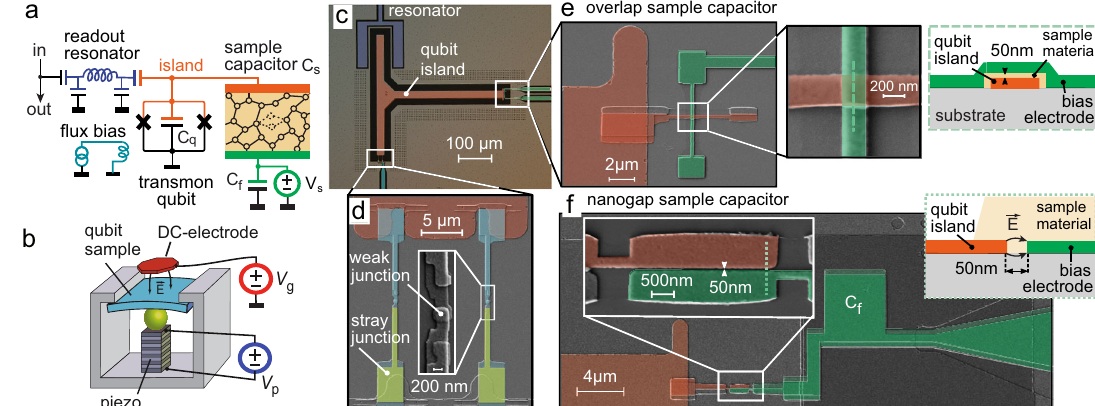
Fig. 1 Experimental setup and qubit sample. a Schematic of the transmon qubit circuit to study TLS in deposited materials. The qubit island (red) is connected to ground by an additional small capacitor containing the material to be studied. b Setup for tuning TLS by applied mechanical strain and a global DC-electric fi eld. c Photograph of the qubit island. d DC-SQUID connecting the qubit island to ground, and a zoom onto one of the small Josephson junctions. The large-area stray junctions are highlighted in light green. e Sample capacitor in overlap geometry as used in this work. It employs a 50-nm thick layer of AlO x as the sample dielectric. f An alternative sample capacitor design consists of two coplanar electrodes separated by a so-called ’ nanogap ’ of a few tens of nm. Here, the sample material can be deposited in a last fabrication step (see inset), or the nanogap can be left uncovered to study individual TLS in native surface